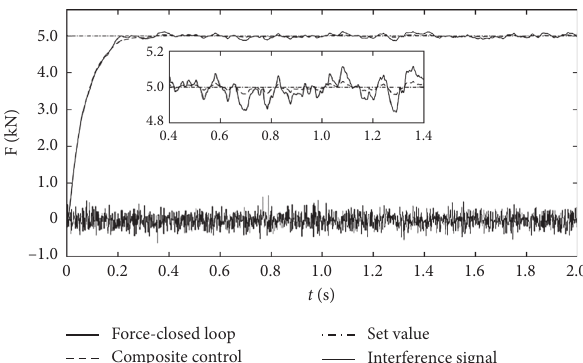
Figure 9: Force closed-loop and composite control anti-interfer- ence simulation contrast